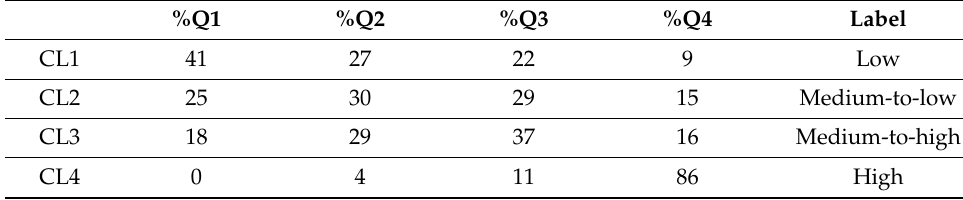
Table 4. Quartile distribution of the E_30 variable in the four